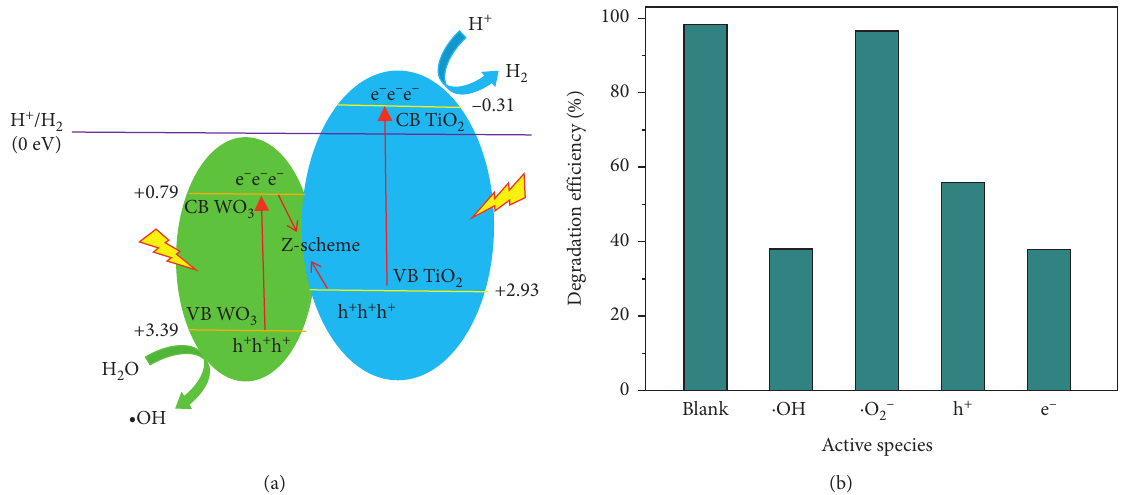
Figure 11: (a) Z-scheme charge transfer and surface redox reactions for 5% WO WO 3 /TiO 2 nanofibers with different